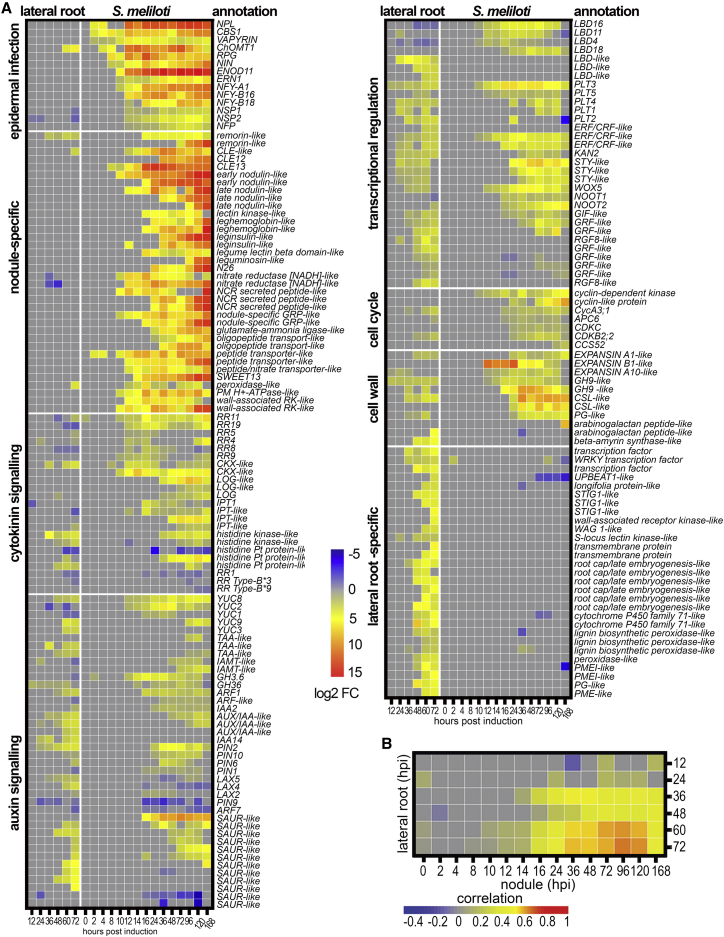
Lateral Roots and Nodules Show Overlap in Gene Expression(A) Heatmap showing selected genes induced during lateral root and nodule development with fold changes ≥±1.5; p < 0.05. Expression depicts log2 fold changes.(B) Correlation heatmap depicting the overlap between genes differentially expressed during lateral root and nodule organogenesis over a time course of development.See also Figures S1 and S2 and Data S1.